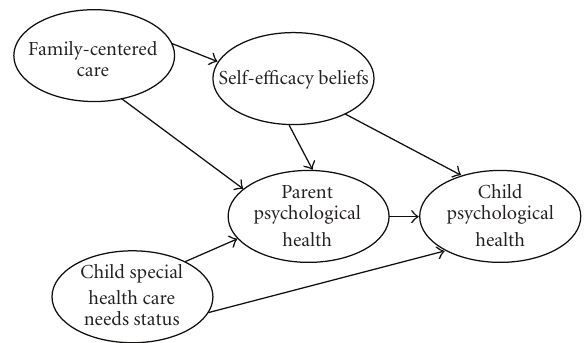
Figure 1: Structural equation model for depicting the e ff ects of family-centered care, self-e ffi cacy beliefs, and child special health care needs on parent and child psychological